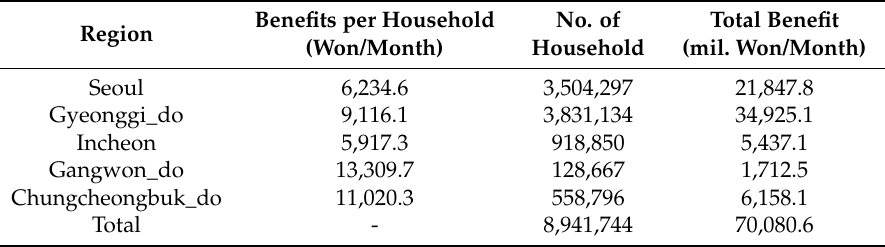
Table 6. Total benefit calculations generated by the Han River by each region.